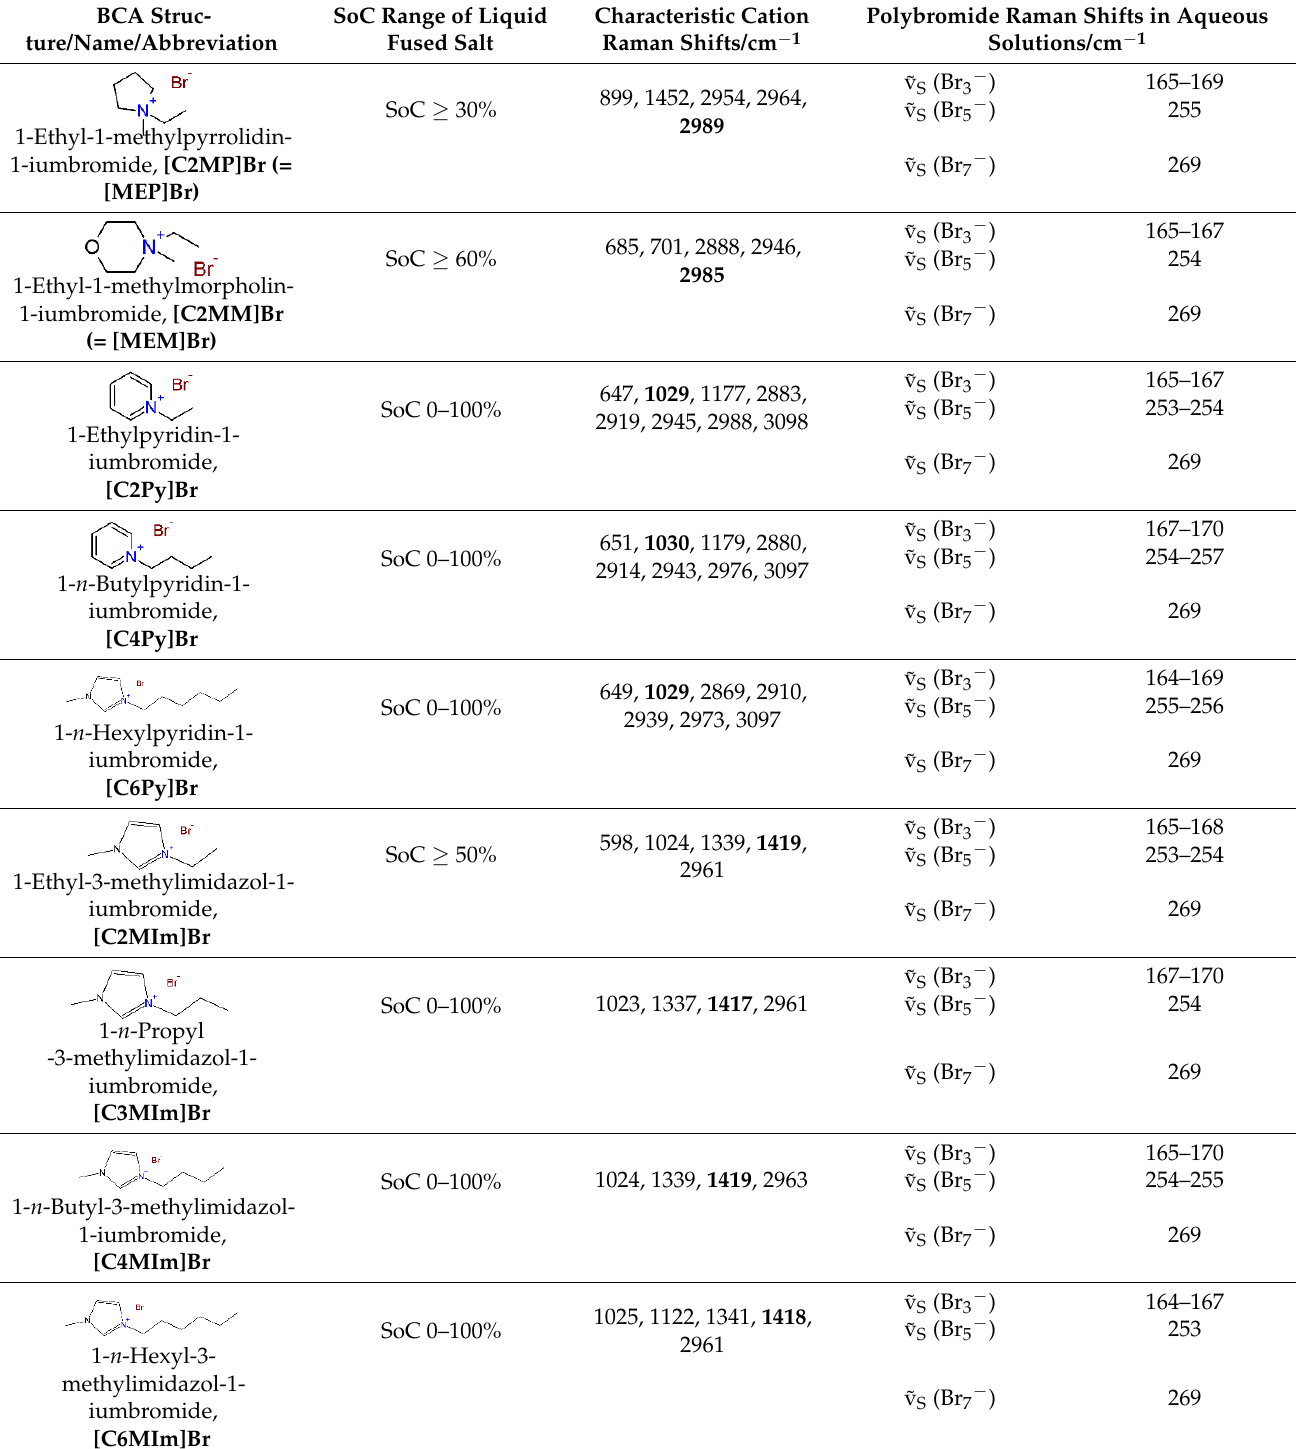
Table 2. Selected BCAs to be investigated over the entire SoC range including the zone in which the second phase is present as a liquid fused salt. Furthermore, characteristic Raman shifts of the [BCA] + cation are shown, whereby the Raman peak with the Raman shift in bold is used to determine the [BCA] + concentration. In addition, the Raman shifts of the symmetrical stretching vibration of the individual polybromides are shown, which are used for the evaluation in Section 2.5.